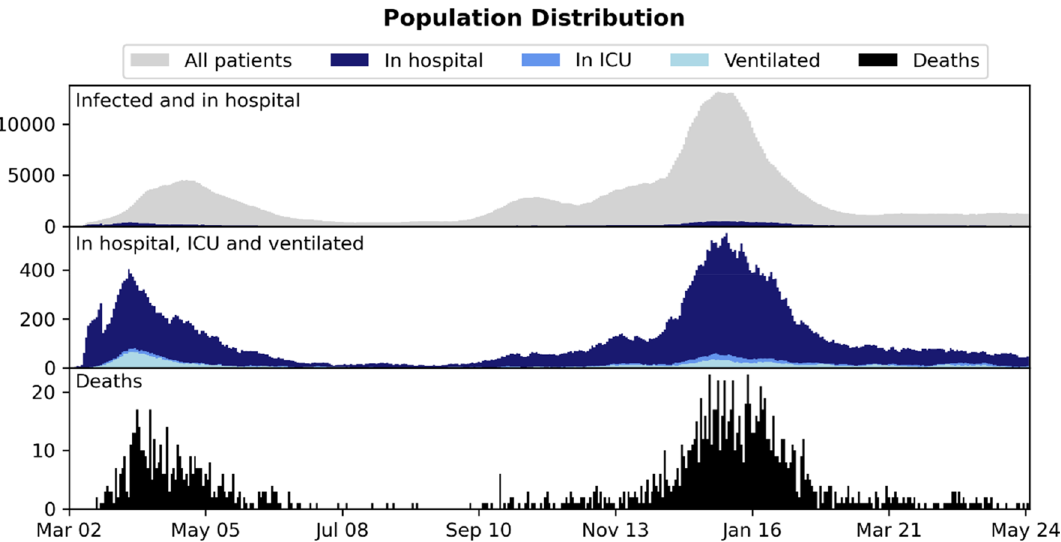
Figure 1. Distribution of patient 24-h snapshots during the period (March 2020–May 2021) considered in the